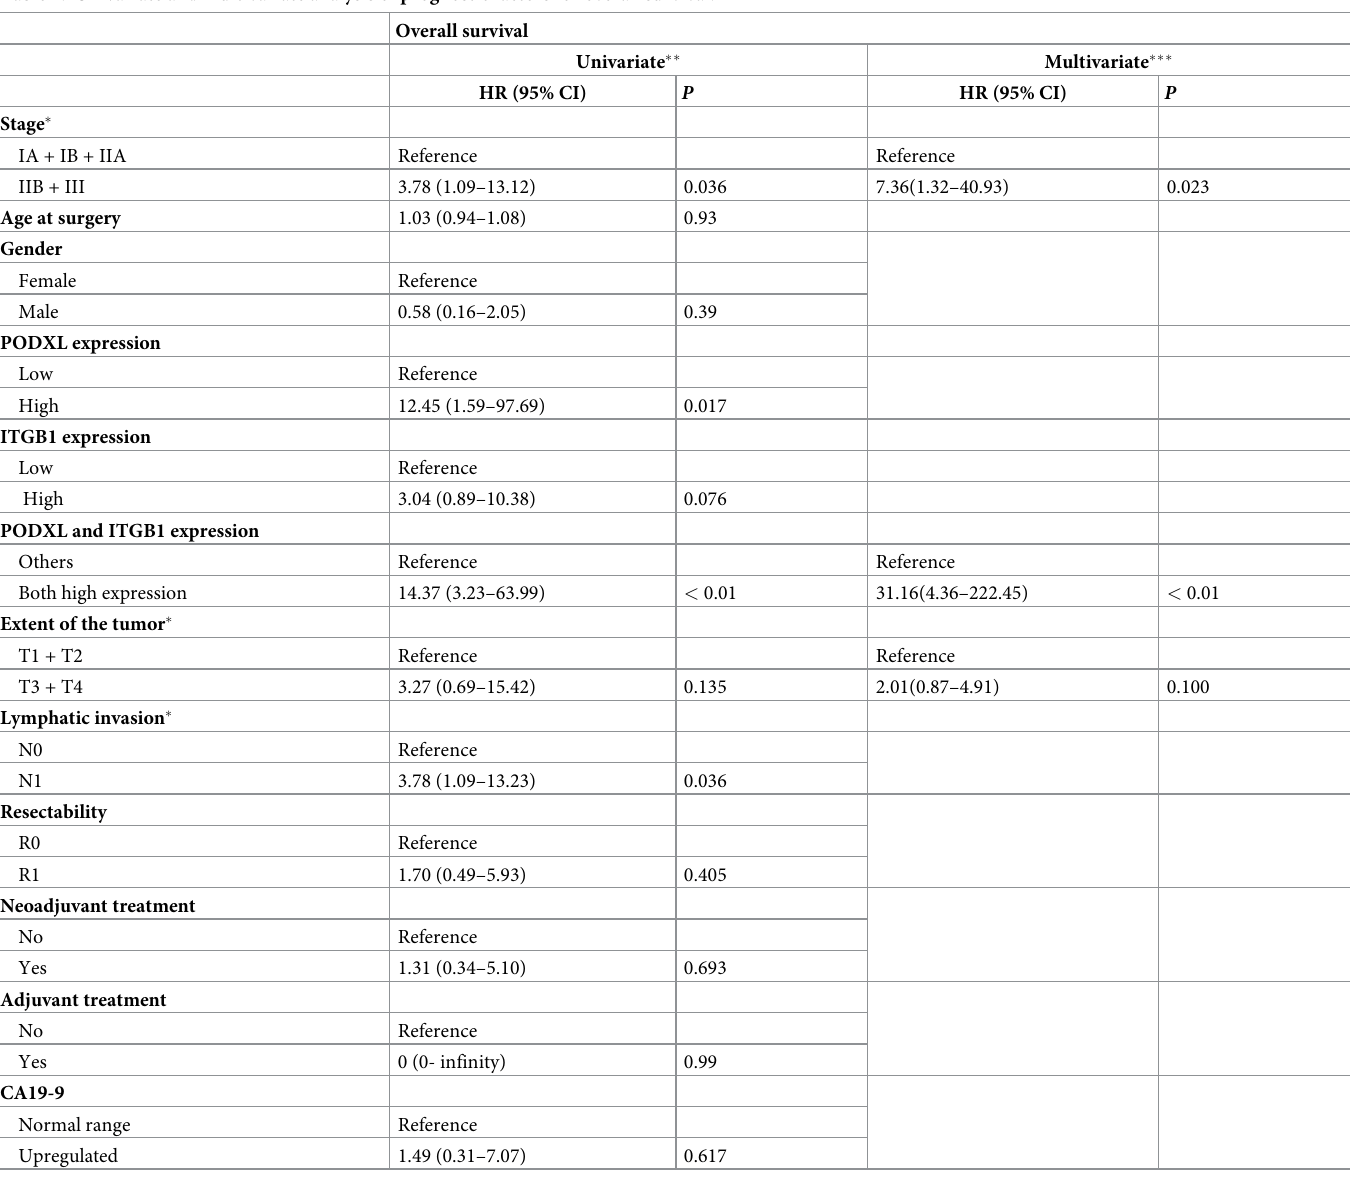
Table 2. Univariate and multivariate analysis of prognostic factors for overall survival. Overall